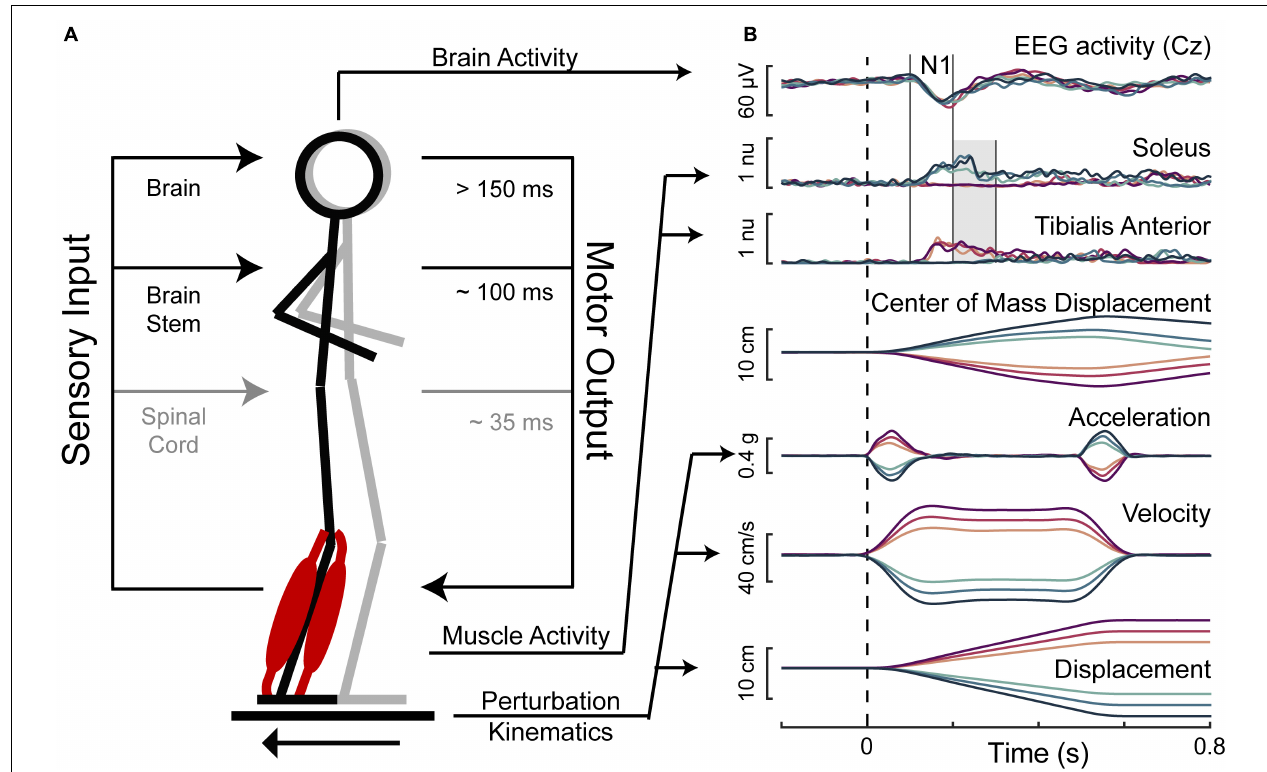
FIGURE 1 | Balance perturbations. (A) The translational support-surface balance perturbation is depicted along with a schematic displaying hierarchical levels of control of the perturbation-evoked muscle activity. (B) Perturbation kinematics and the measured response variables are shown for an example participant with forward movements of the floor represented in magentas and backward movements of the floor represented in blues, with darker colors for larger perturbations. Perturbation onset is indicated with the dashed vertical line. Solid vertical lines indicate the time window of 100–200 ms, in which the cortical N1 and the early phase of muscle activity were assessed. The shaded gray area indicates the time window of 200–300 ms, in which the late phase of muscle activity was assessed.